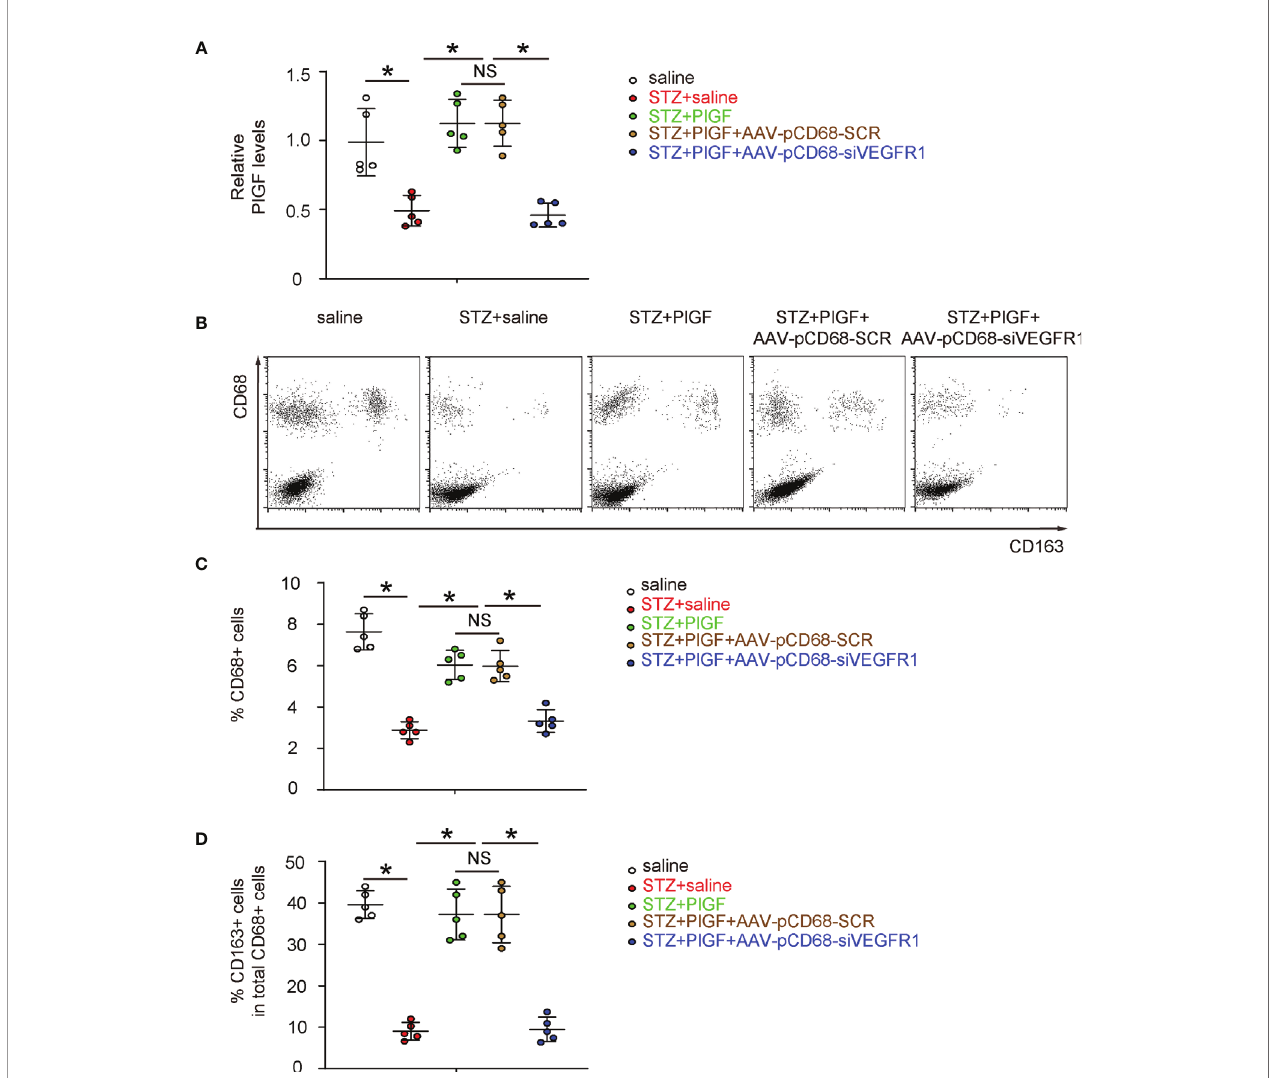
FIGURE 6 | Macrophage-depletion of VEGF1R reduces macrophage number and reduces M2 polarization. (A) ELISA for PlGF levels in tissue from all experimental groups. (B) Representative fl ow charts for analysis and sorting for CD68 and CD163. (C, D) Quanti fi cation of CD68+ macrophage percentage (C) and CD163+ cells in total CD68+ cells (D) . *p < 0.05. NS, non-signi fi